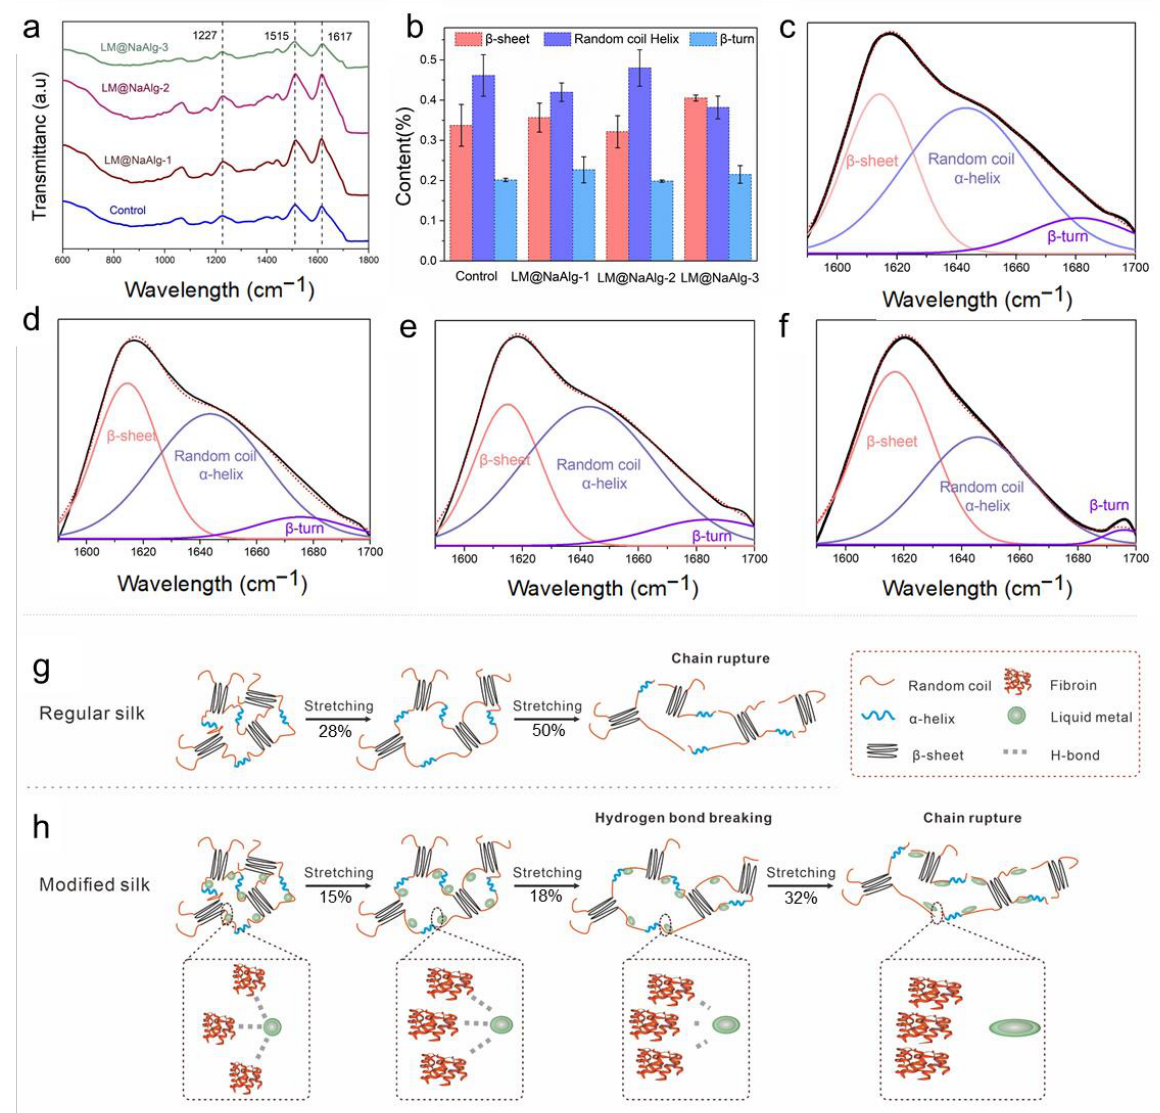
Figure 4. Effect of the LM@NaAlg nanodroplets on the secondary structures of the obtained silks. ( a ) FTIR spectra of the degummed silk fibroins of the silk samples; ( b ) contents of the secondary structures of the silk samples acquired according to the deconvoluted amide I band spectra; ( c – f ) deconvolution of the FTIR spectra in the amide I band of ( c ) Control, ( d ) LM@NaAlg-1, ( e )